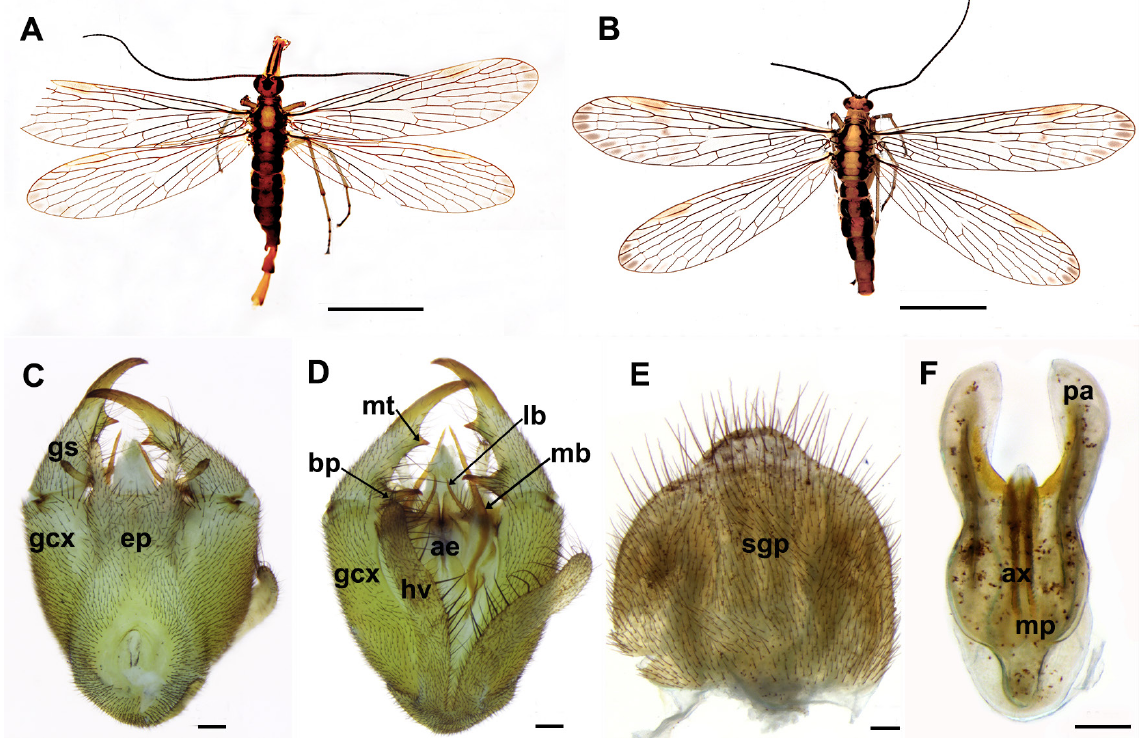
Fig. 2. Dicerapanorpa bifurcata sp. nov. A . ♂, holotype, dorsal view, NWAU. B . ♀, paratype, dorsal view, NWAU. C – D . ♂, genital bulb in dorsal and ventral views, respectively. E . ♀, subgenital plate, ventral view. F . ♀, medigynium, ventral view. Scale bars: A–B = 5.0 mm; C–F = 0.2